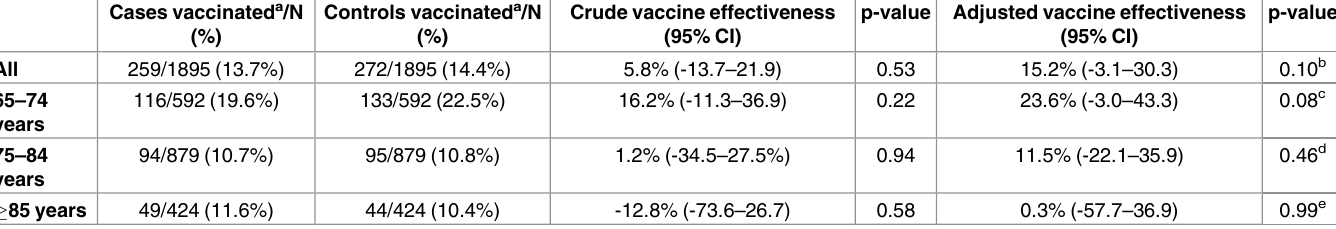
Table 3. Crude and adjusted effectiveness of PPSV23 against hospitalization due to community-acquired pneumonia. Cases vaccinated a